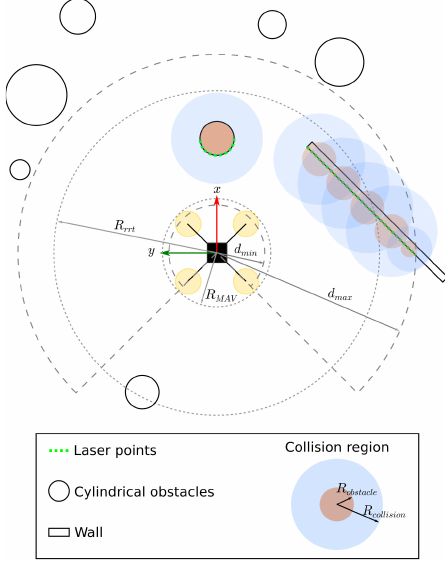
Figure 5. MAV in a environment with 7 cylindrical trees and and a wall. Only the obstacles between d min and d max are used to build the local map. Obstacles outside the circle of radius R rrt are not used during path